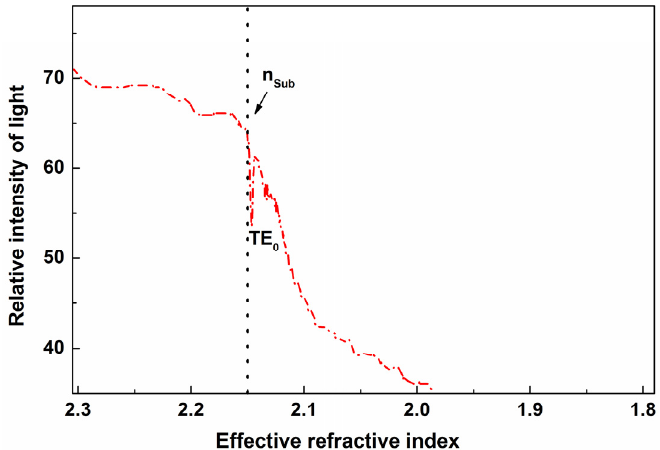
Figure 1. Mode-line spectrum of crystal waveguide irradiated by energetic oxygen ions.